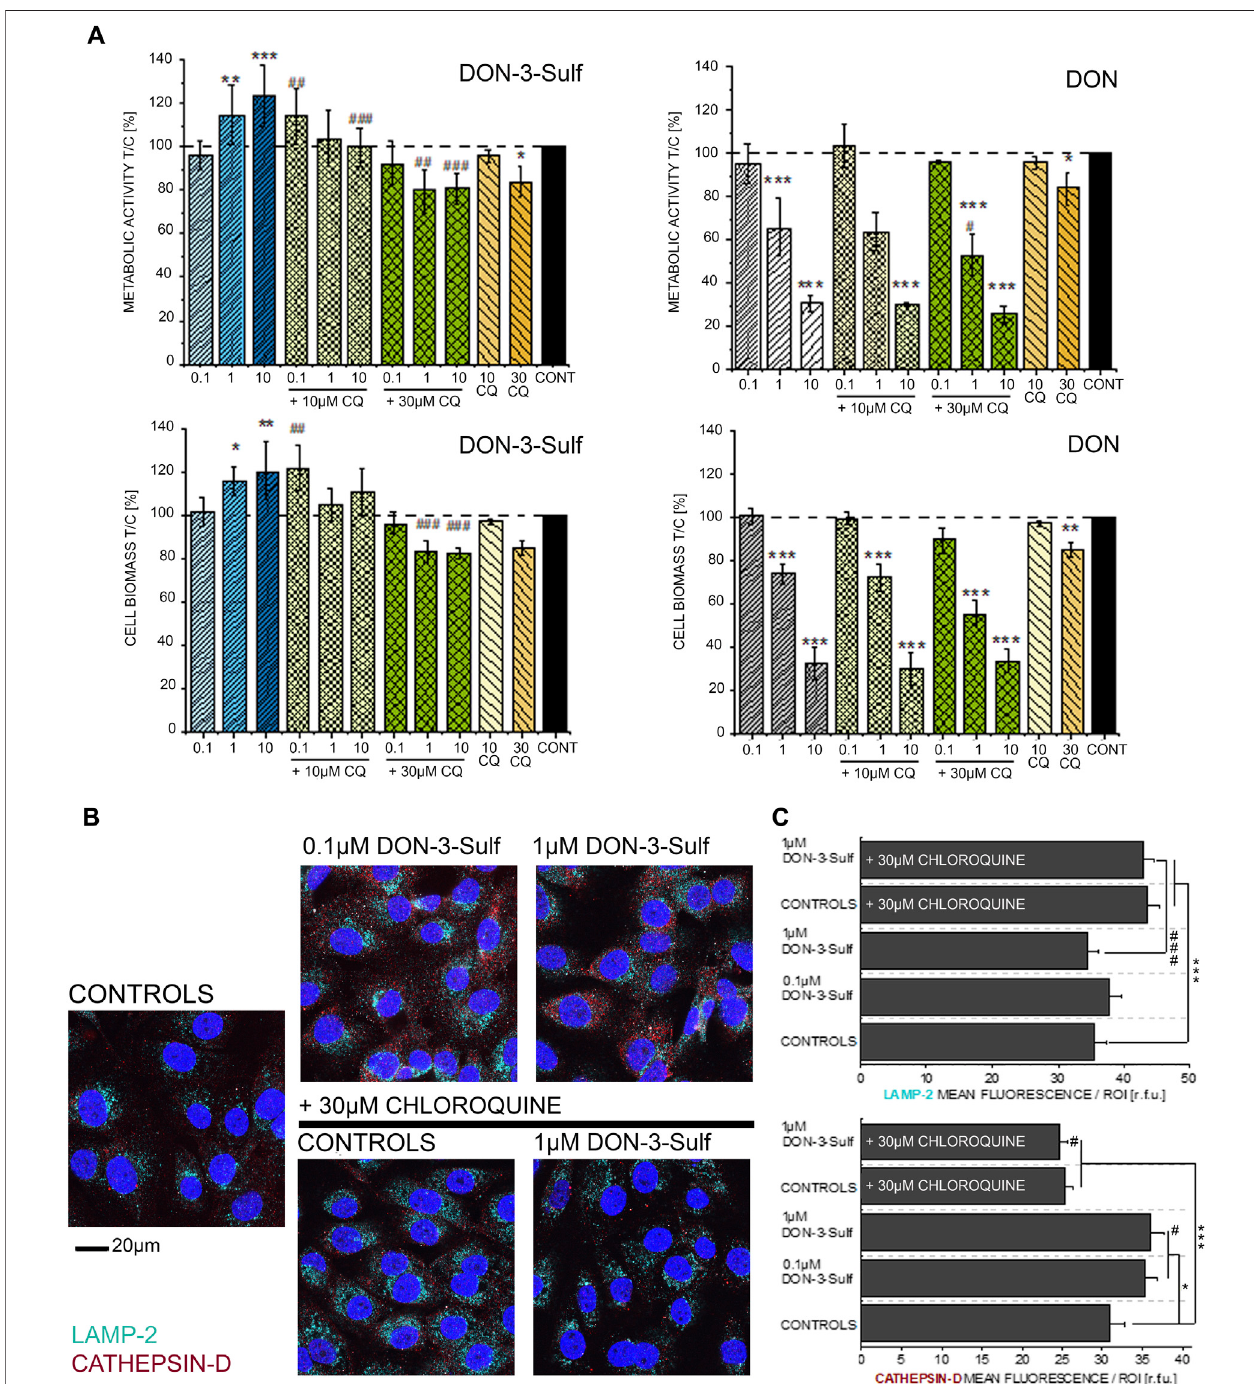
FIGURE 2 | (A) Effect of DON-3-Sulf and DON on T24 cell viability measured as metabolic activity (Alamar blue assay) and cell biomass (crystal violet assay). * indicates signi fi cant difference in comparison to controls and # difference between incubation conditions with and without CQ (#*: p ≤ 0.05; ##**: p ≤ 0.01; ###***: p ≤ 0.001). (B) AppearanceofT24cellsafter immuno fl uorescence localizationofLAMP-2 (lightblue)andcathepsinD(red).Cellnucleiaredepictedinblue(DAPI; scale bar: 20 µm). (C) Quanti fi cation of the fl uorescence signal of LAMP-2 and cathepsin D expressed as mean/ROI (relative fl uorescent units; r. f.u.); n > 60 cells from three different preparations. * indicates signi fi cant difference in comparison to controls and # difference between incubation conditions with and without CQ (#*: p ≤ 0.05; ###***: p ≤ 0.001) at the Student ’ s t -test.